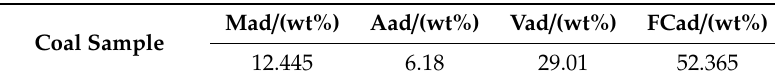
Table 1. Proximate analysis results of coal